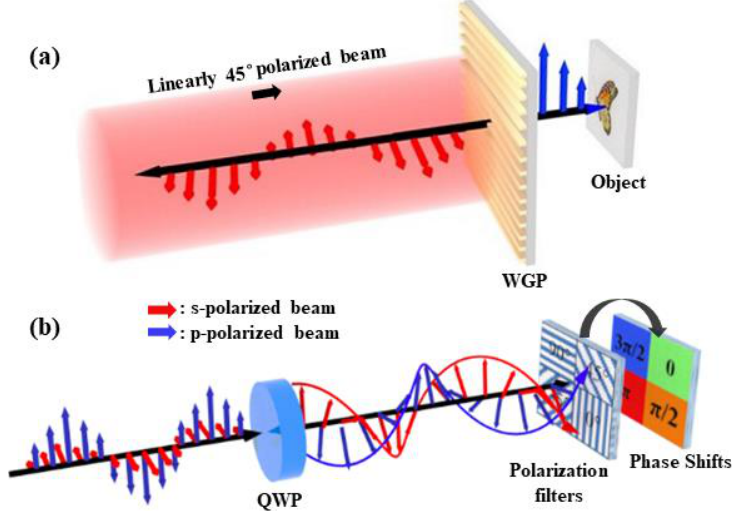
Figure 1. ( a ) Conceptual schematic of orthogonal polarized beam generation with the wire grid polarizer (WGP); ( b ) Schematic of the space division multiplexing mechanism with QWP and polarization filters in the polarized camera for single-shot detection of multiple phase-shifted holograms.